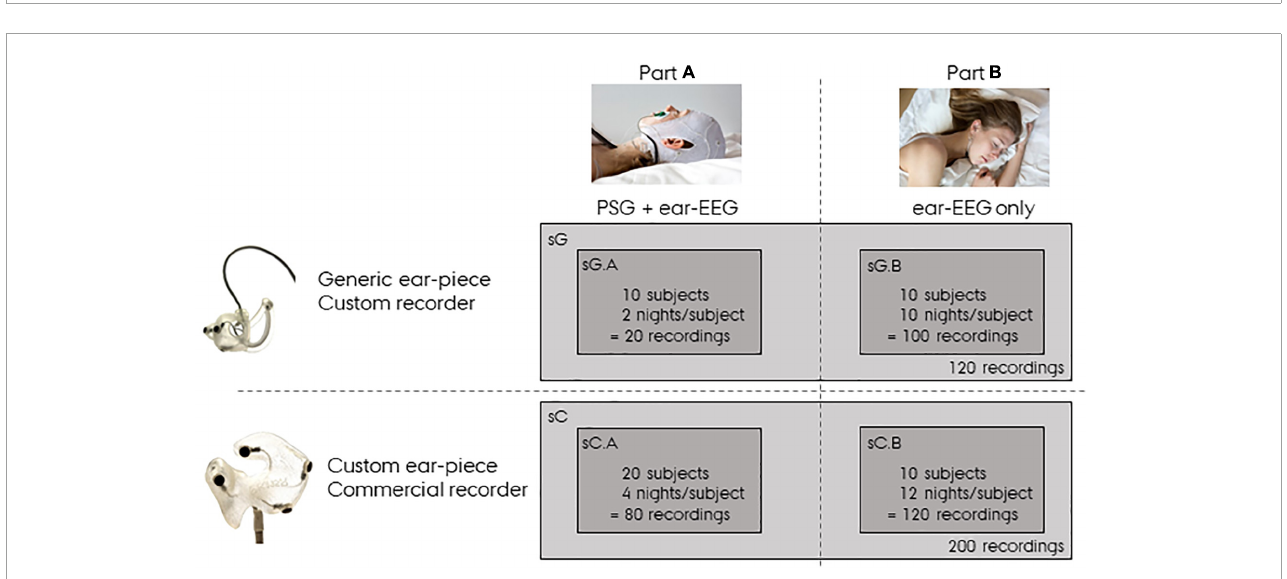
FIGURE2 Overview of the data. sG refers to data from the study with generic earpieces, and sC to data from the study with custom earpieces. Both datasets have a Part A and a Part B. Part A were recorded with both polysomnography (PSG) and ear-centered electroencephalography (ear-EEG), whereas Part B were recorded from ear-EEG